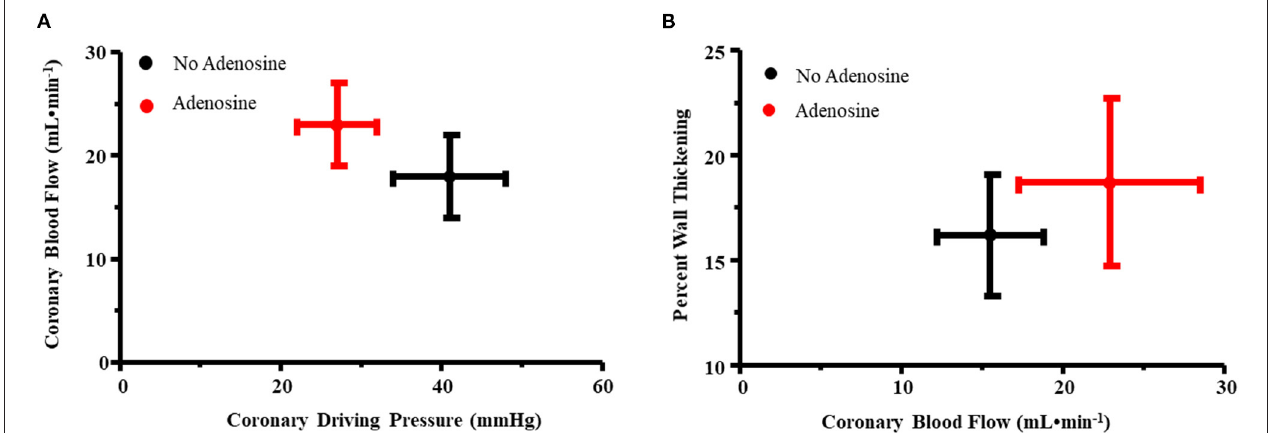
FIGURE 2 | (A) Relation between coronary driving pressure (difference between distal coronary and RA pressures, x-axis) and coronary blood flow (y-axis) for the primary stenosis in all nine dogs prior to and during adenosine administration. An upward and leftward shift was noted with adenosine, indicating a reduction in myocardial vascular resistance. (B) Relation between coronary blood flow (x-axis) and percent wall thickening (y-axis) before and during adenosine administration. An upward and rightward shift occurred, indicating an increase in percent wall thickening during adenosine administration resulting from an increase in coronary blood flow.